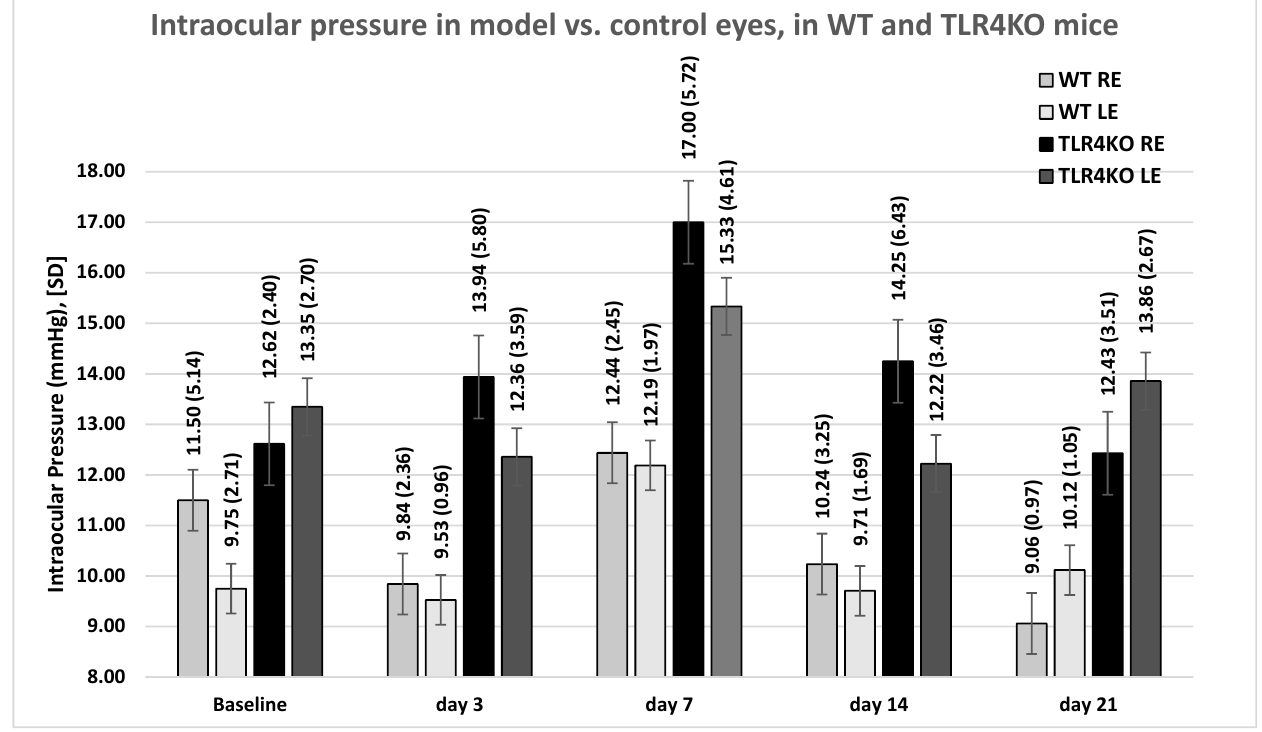
Figure 1. IOP measurements. Mean (SD) IOP values in the model (right) versus control (left) eyes of WT and TLR4KO mice by day of measurement. WT, wild type; TLR4KO, toll-like receptor 4 knockout; RE, right eyes; LE, left eyes.